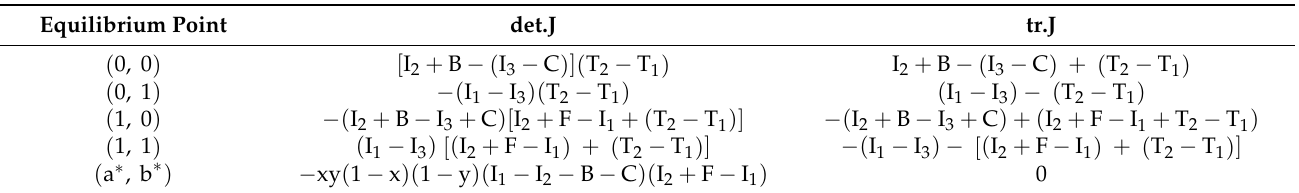
Table 2. Values of the determinant and trace of the Jacobi matrix of the game system between farmers and agricultural enterprises. det.J tr.J